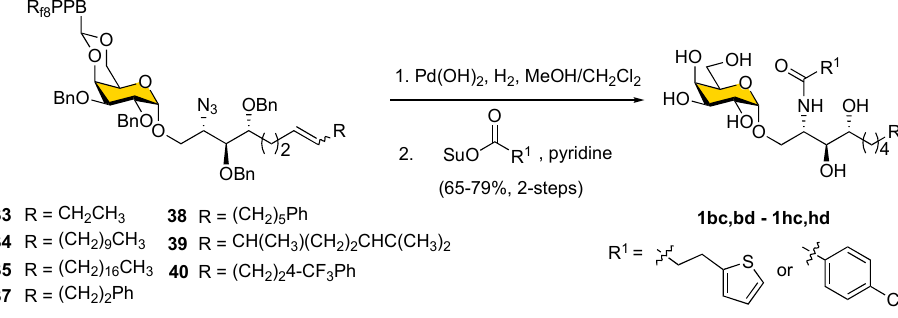
Scheme 8. A modified strategy for the synthesis of α -GalCer analogs ( 1bc , bd – 1hc , hd